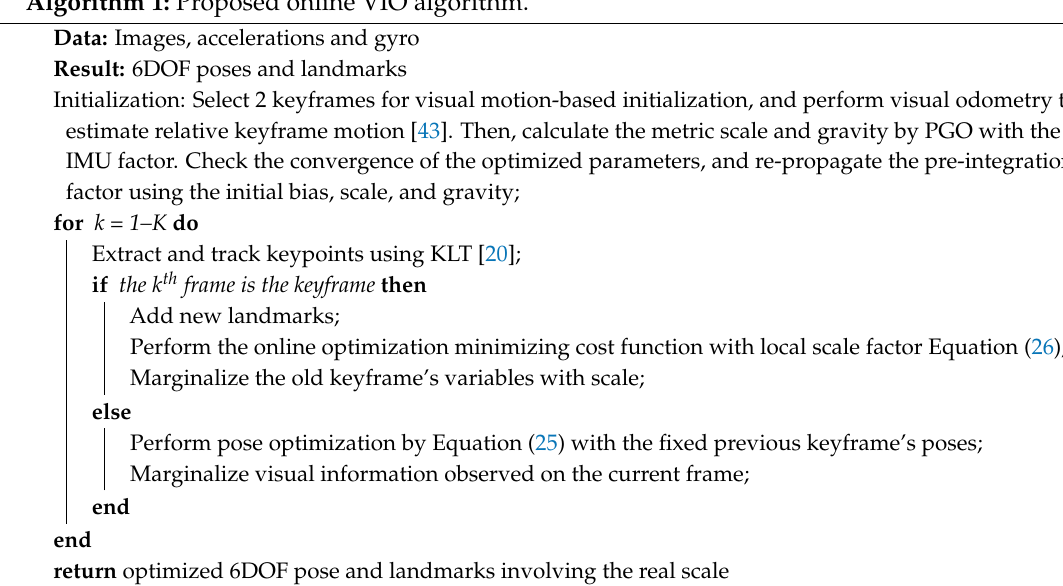
Algorithm 1: Proposed online VIO algorithm. Data: Images, accelerations and